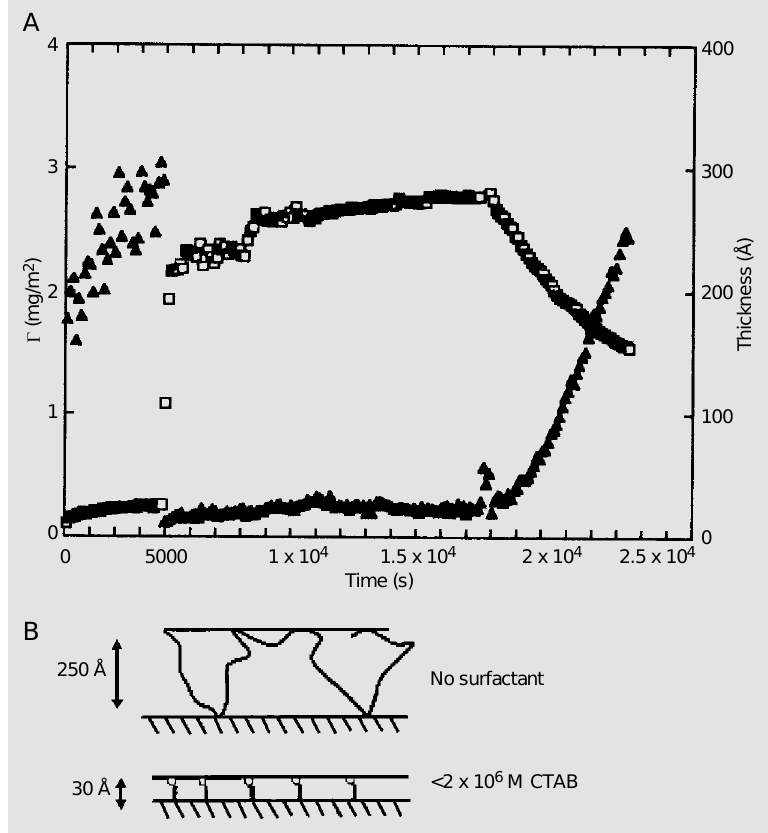
Figure 9. A , Adsorbed amount (open squares) and adsorbed layer thickness (triangles) as a function of time. The DNA (700 bp) is added at time 0 (0.06 mg/ml), at t 5000 s cetyltri- methylammonium bromide (CTAB) is added at a concentration of 1.5 x 10 -6 M. Then the CTAB concentration is increased stepwise up to t 17,000 s when rinsing is started. Reprinted from Ref. 40, with permission. B , Schematic representation of the system. With no surfactant added DNA adsorbs slowly onto the surface. With the addition of the surfactant the adsorbed amount increases but the adsorbed layers